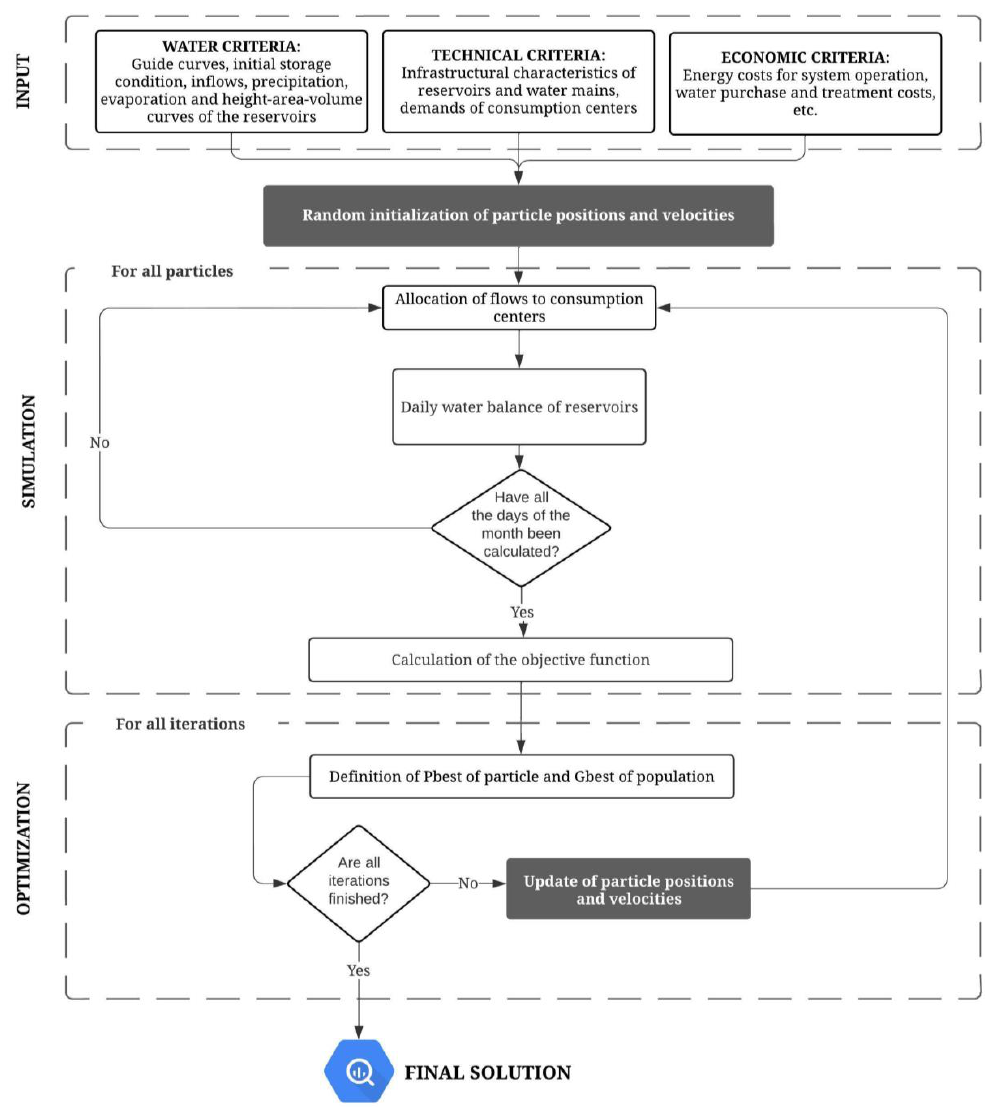
Figure 5. DSS optimization